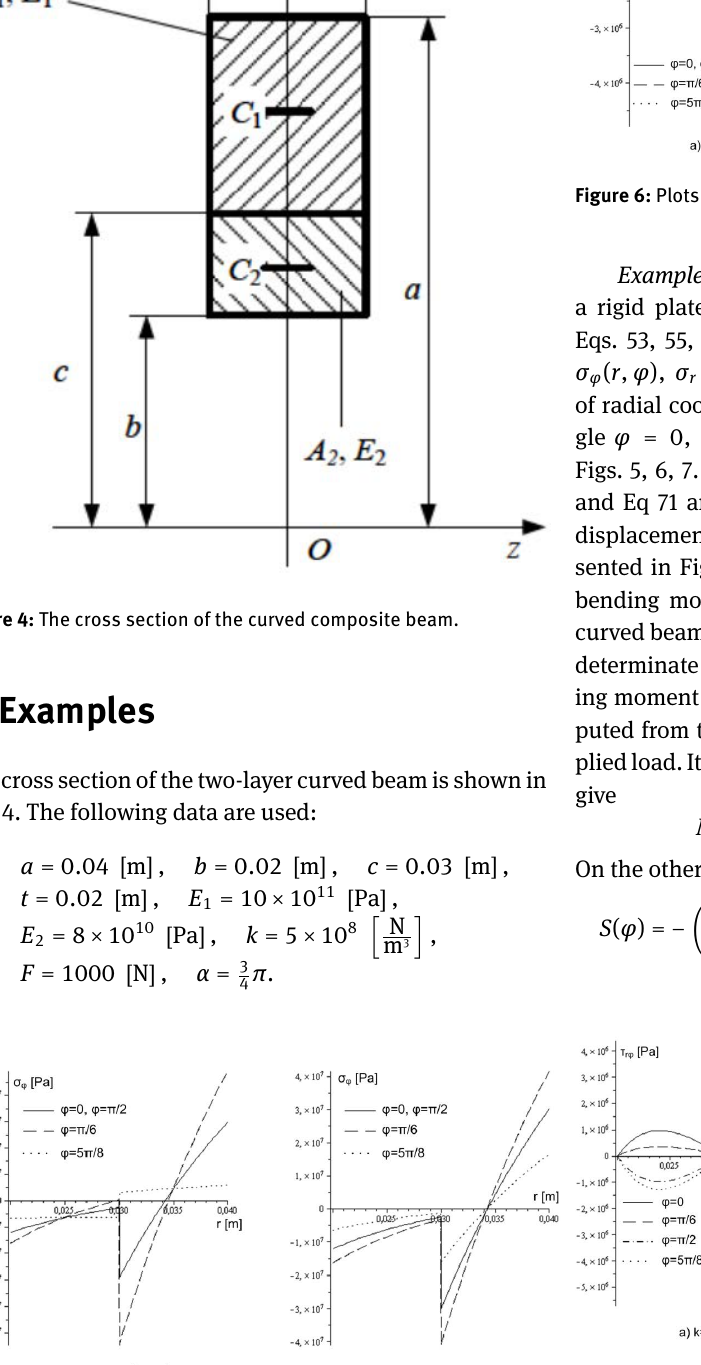
Figure 7: Plots of τ rφ for Example